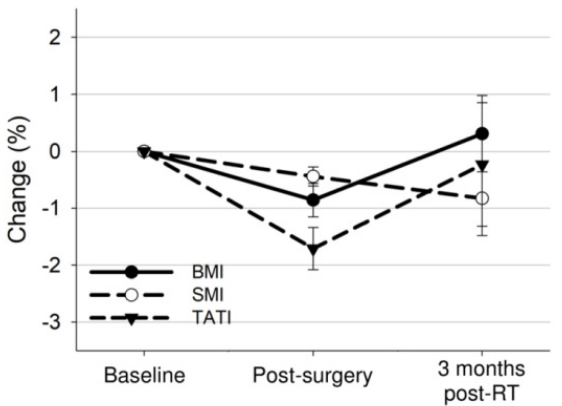
Figure 2. Overall mean changes with 95% confidence interval bars in BMI, SMI, and TATI from baseline to 3 months after treatment completion.